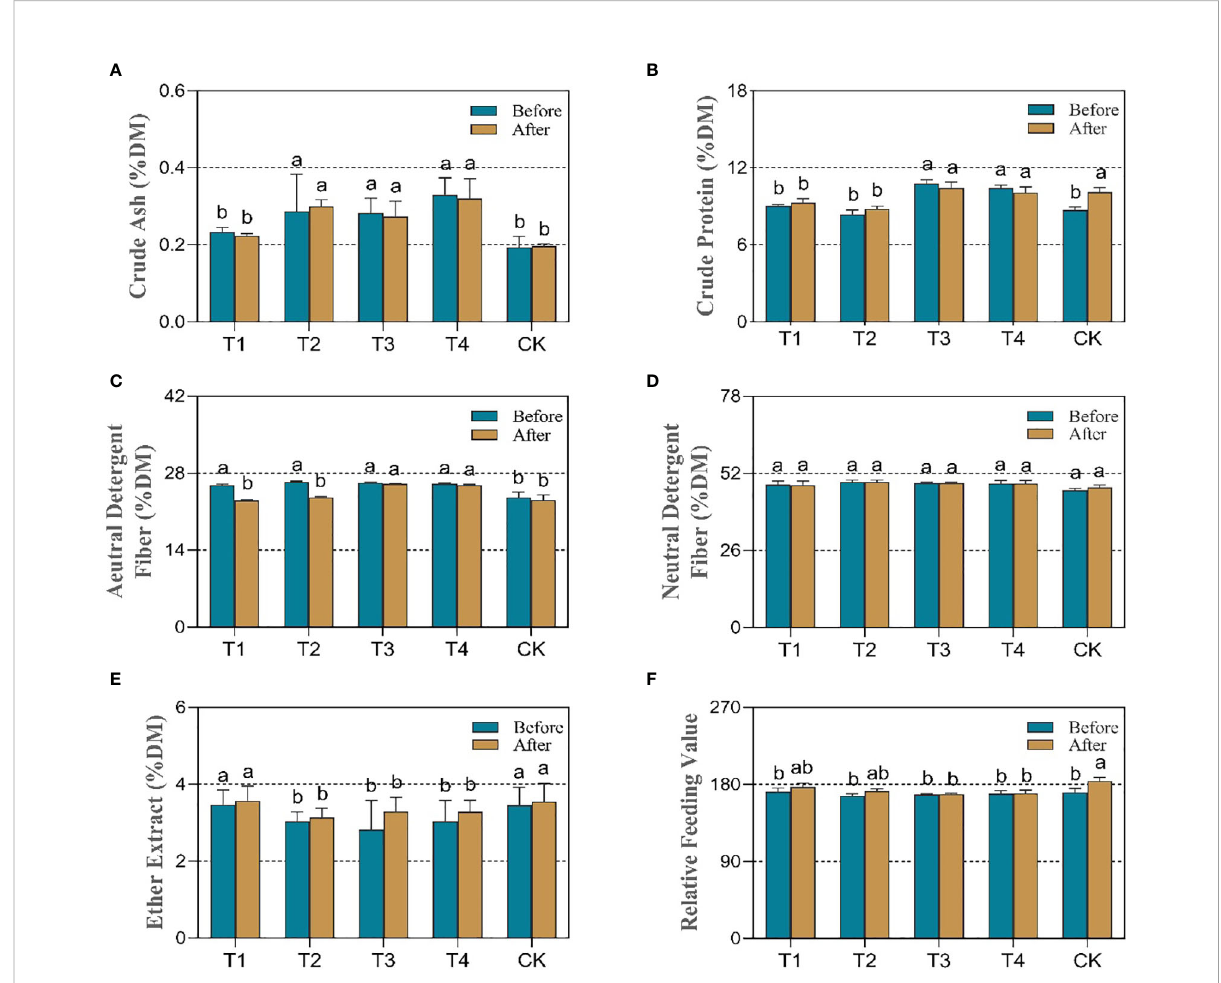
FIGURE 3 Effect of different periods of drought treatment on the dynamic nutritional quality of maize before (blue bar) and after treatment (yellow bar). The fi gure includes crude ash (A) , crude protein (B) , acid detergent fi ber (C) , neutral detergent fi ber (D) , ether extract (E) , and relative feeding value (F) . T1, seedling stage; T2, elongation stage; T3, fl owering stage; T4, maturity stage. Different letters above the bars indicate that the values differ signi fi cantly